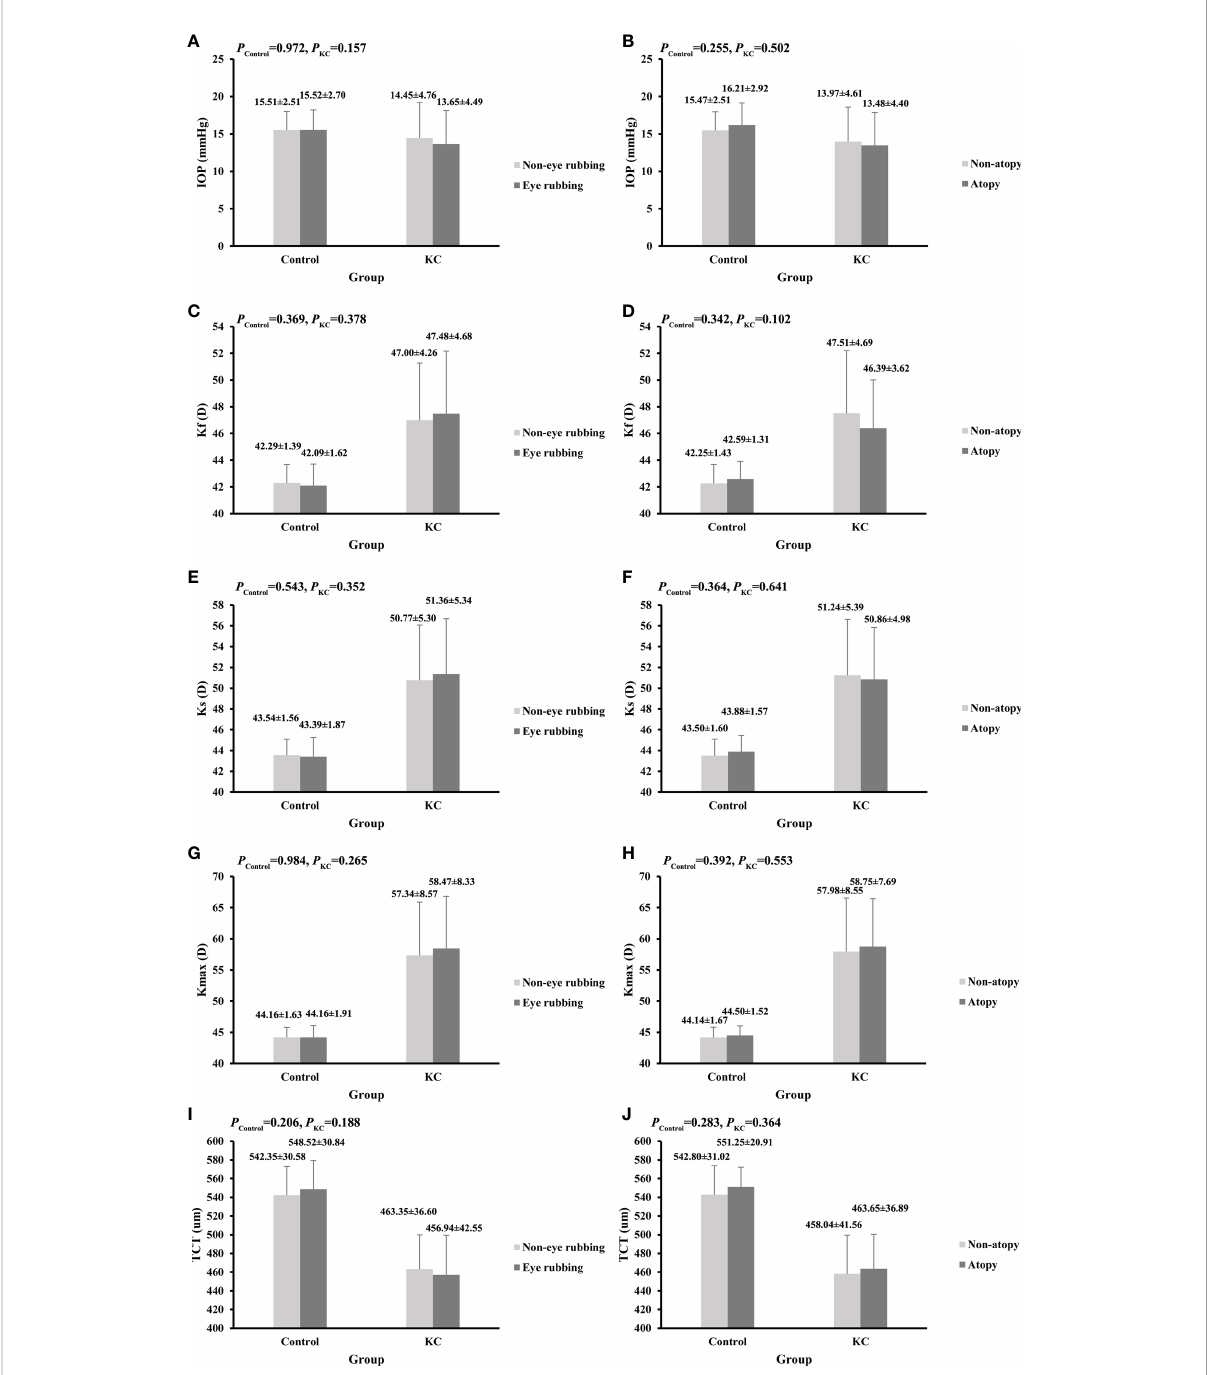
FIGURE 1 Comparisons of corneal parameters in KC and control groups. (A) IOP between eye rubbing and non-eye rubbing; (B) IOP between atopy and non-atopy; (C) Kf between eye rubbing and non-eye rubbing; (D) Kf between atopy and non-atopy; (E) Ks between eye rubbing and non-eye rubbing; (F) Ks between atopy and non-atopy; (G) Kmax between eye rubbing and non-eye rubbing; (H) Kmax between atopy and non-atopy; (I) TCT between eye rubbing and non-eye rubbing; (J) TCT between atopy and